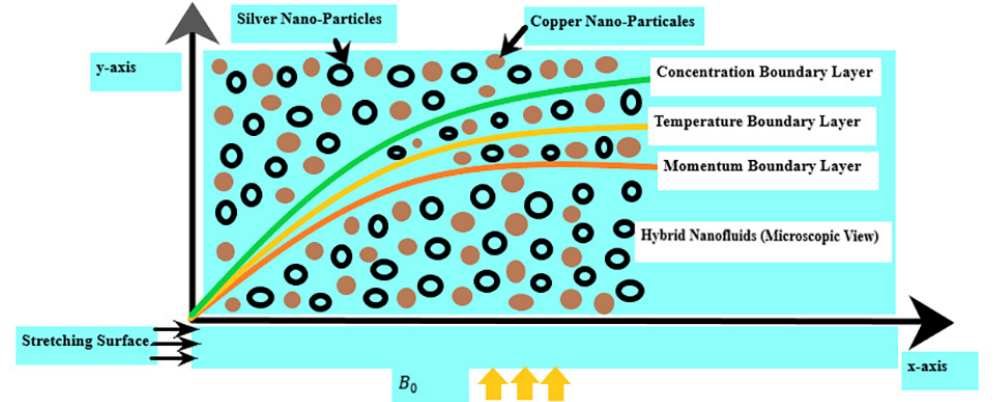
Figure 1. The geometry of the problem.